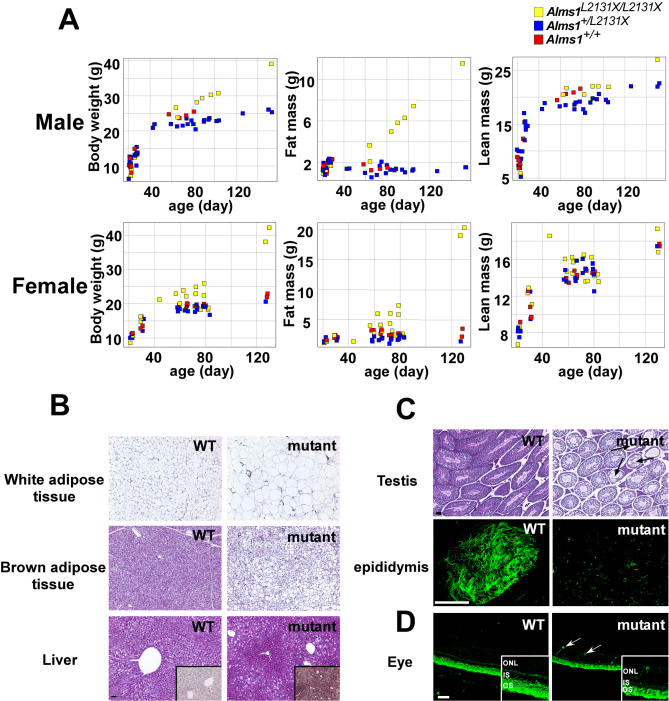

Alms1L2131X/L2131X Mice Recapitulate Human Alström Syndrome(A) Alms1L2131X/L2131X mice gain more fat mass than heterozygote or wild-type controls but equivalent lean mass.(B) Histological examination of Alms1L2131X/L2131X mice and wild-type littermate control. Insets show oil red O staining of frozen liver sections.(C) Testis H&E sections show degeneration of seminiferous tubules (arrow), which have reduced numbers of germinal cells. Reduced numbers of sperm flagella with decreased length are observed in the epididymus of Alms1L2131X/L2131X mice (anti-acetylated tubulin, green). H&E, hematoxylin-eosin.(D) Rhodopsin staining in the outer nuclear layer cell bodies is seen in rare cells in the Alms1L2131X/L2131X animals (arrows) but not in wild-type littermate controls. Insets illustrate higher magnification images. ONL, outer nuclear layer; IS, inner segment; OS; outer segment. Scale bars, 50 μm.